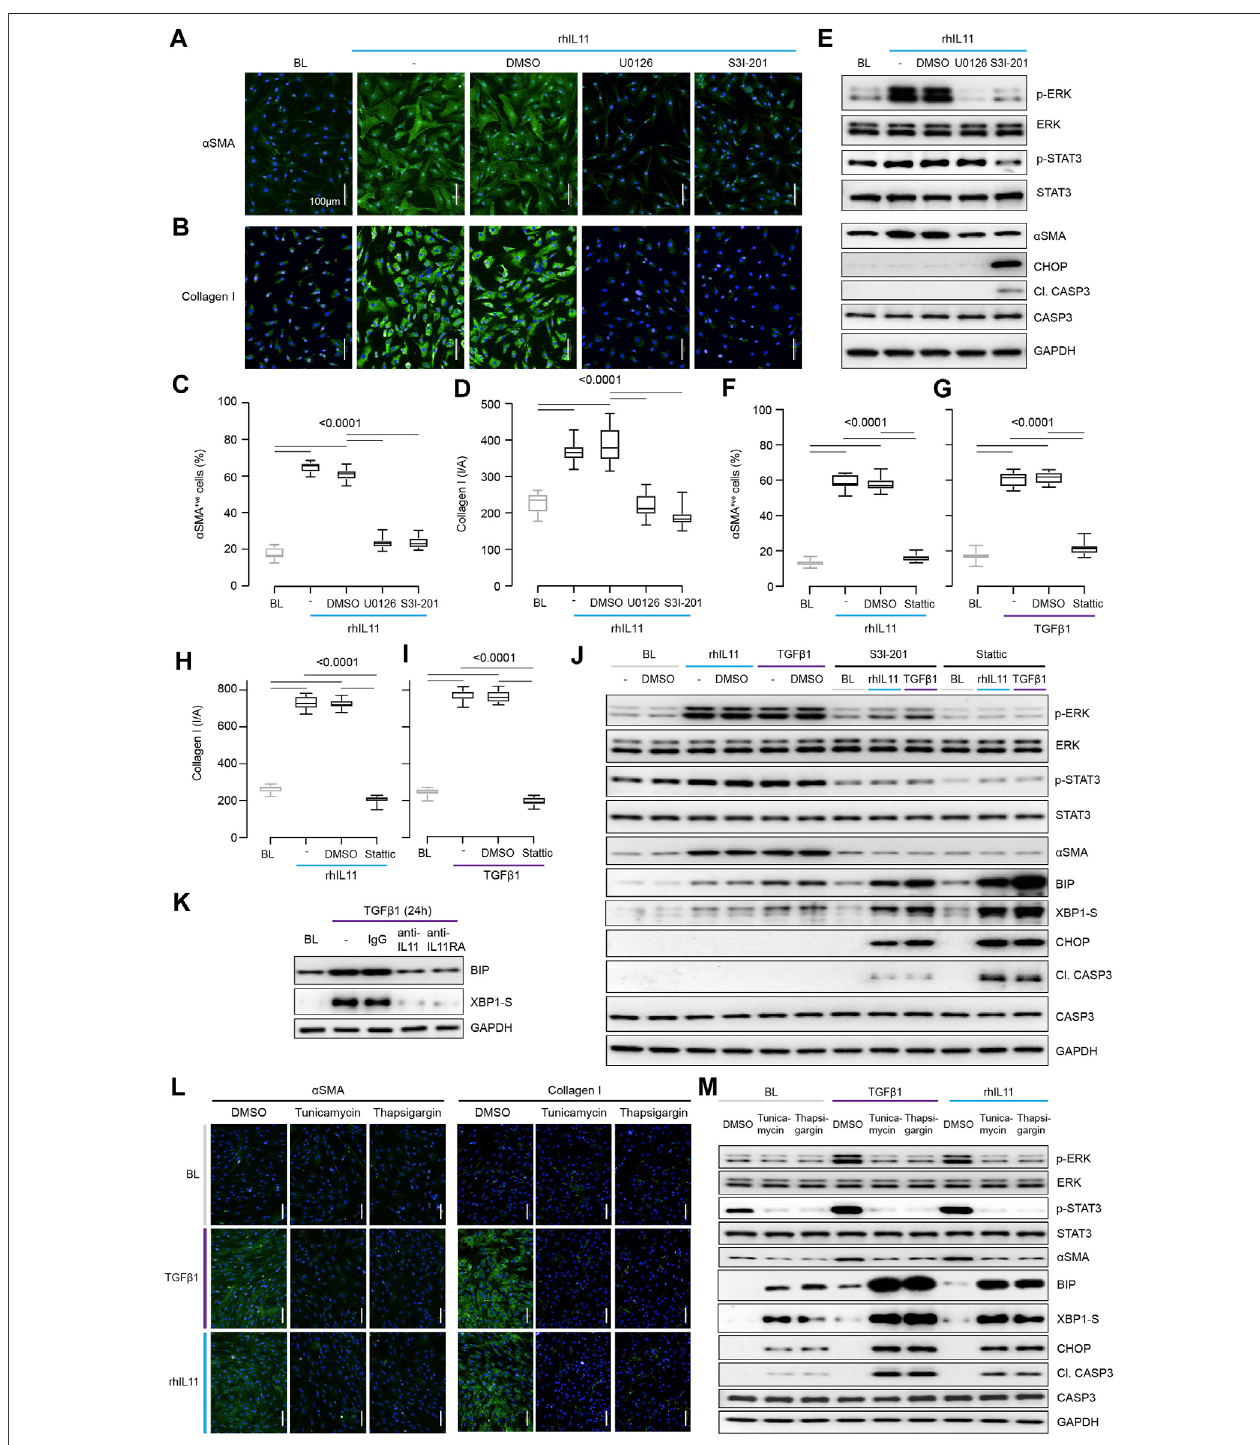
FIGURE 2 | Inhibition of STAT3 in TGF β 1-or IL11-stimulated fi broblasts causes ER stress-related fi broblast dysfunction mimicking effects ofgeneric ER stressors. (A – E) Effects of U0126 or S3I-201 on rhIL11-stimulated HCFs. (A,B) IF images (scale bars, 100 μ m; n (cid:2) 3) and (C,D) quanti fi cation of ⍺ SMA +ve cells and Collagen I immunostaining ( n (cid:2) 14). (E) Western blots showing ERK, STAT3, and Caspase3 activation status and ⍺ SMA and CHOP protein expression ( n (cid:2) 1). (F – I) Quanti fi cation of (F,G) ⍺ SMA +ve cells and (H,I) Collagen I immunostaining following stimulation with (F, H) rhIL11 or (G, I) TGF β 1 in the presence of Stattic ( n (cid:2) 14). (J) Effects of S3I-201 or Stattic on the activation of ERK, STAT3, and Caspase3 and on the expression of ⍺ SMA, CHOP, and XBP1-S at baseline and in TGFF β 1-or IL11-stimulated HCFs ( n (cid:2) 1). (K) Western blots of BIP and XBP1-S from IgG/anti-IL11/anti-IL11RA-treated TGF β -stimulated HCFs ( n (cid:2) 1). (L,M) (L) Representative IF images